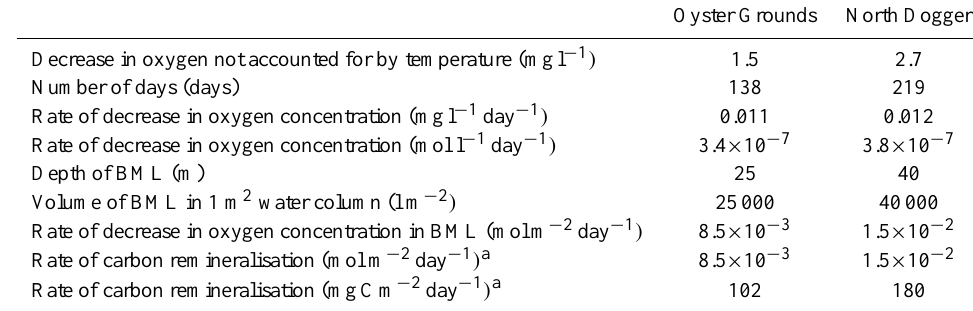
Table 4. Estimates of carbon remineralisation accounted for by overall decrease in oxygen concentration at Oyster Grounds and North Dogger.